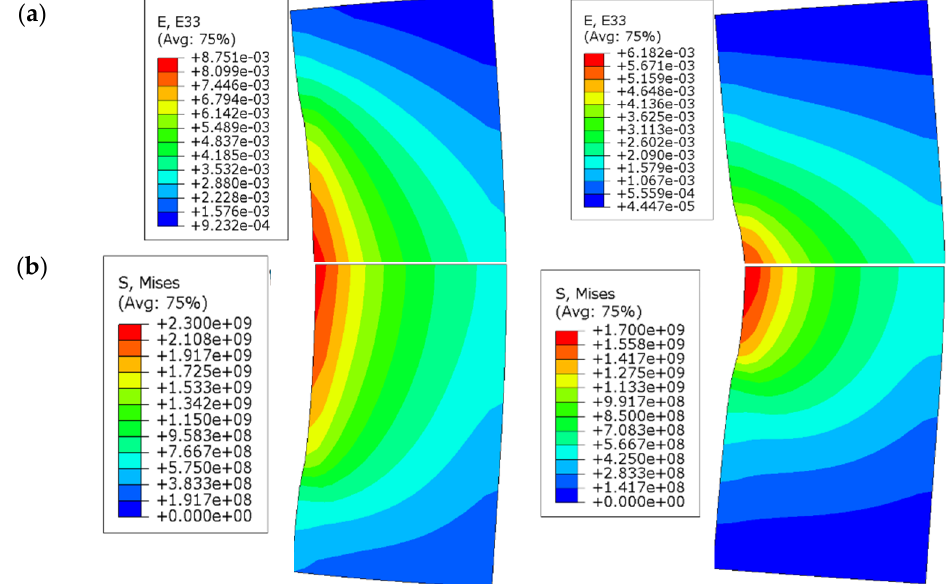
Figure 3. Loading definition: internal pressure and shear stress applied on the inner surface of the ring: ( a ) hi = 30 mm; ( b ) hf = 15 mm.